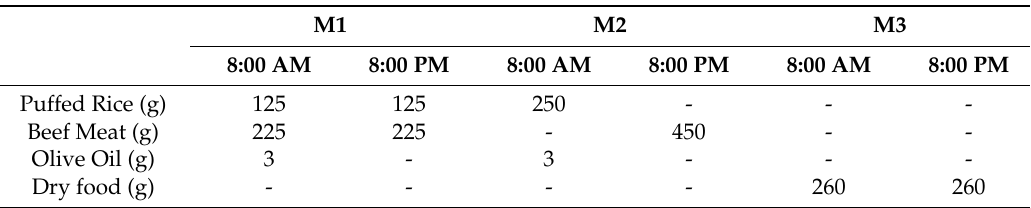
Table 2. Amount of administered food for 30 kg BW (as fed basis). M1 = Meal 1; M2 = Meal 2; M3 = Meal